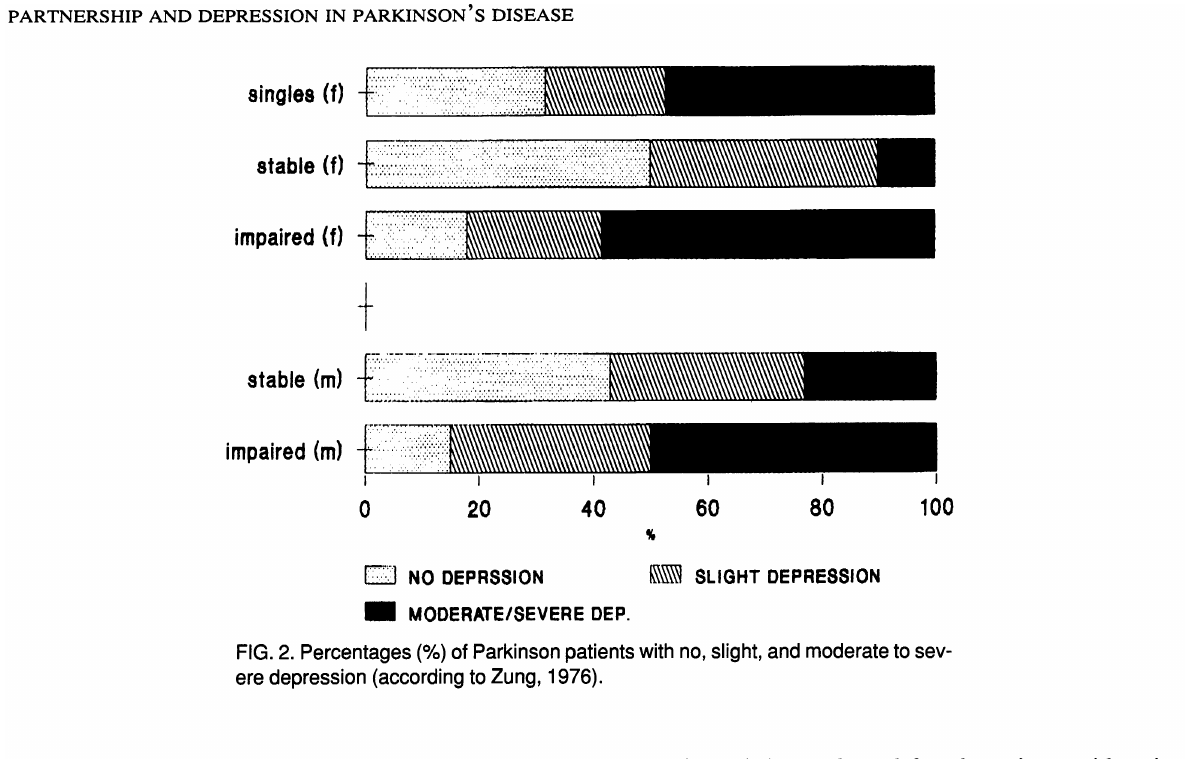
FIG. 2. Percentages (%) of Parkinson patients with no, slight, and moderate to sev ere depression (according to Zung,